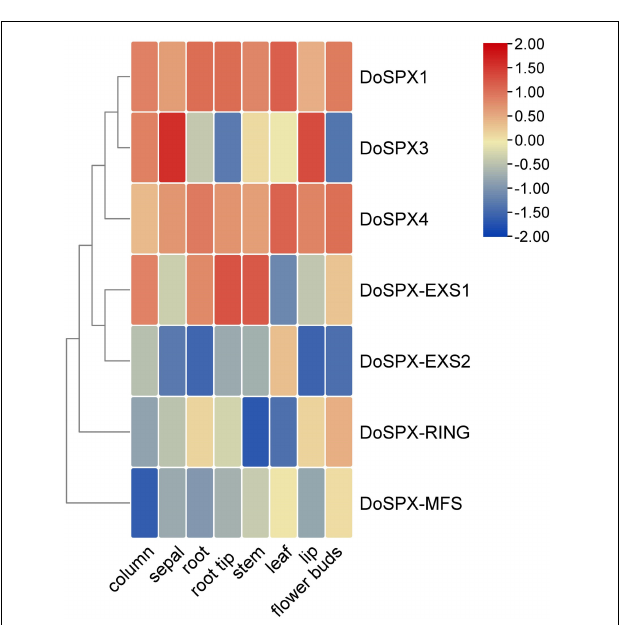
FIGURE 3 | Expression profiles of DoSPX genes in 8 tissues of D. officinale . Blue to red indicates low to high expression levels of the gene.